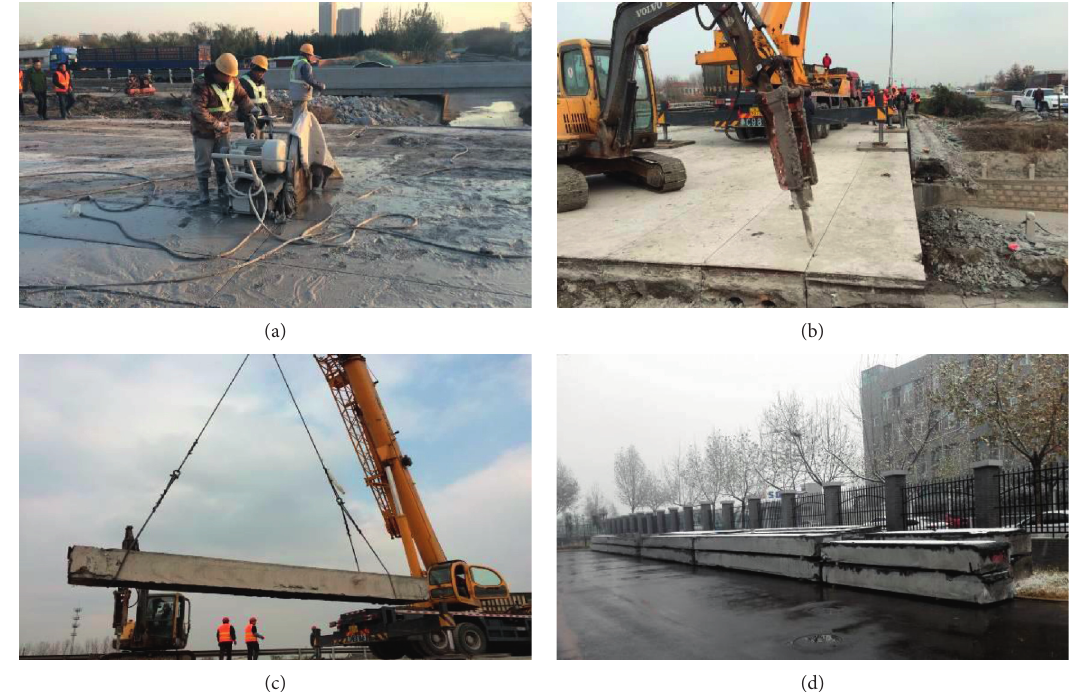
Figure 1: In situ construction: (a) cutting; (b) demolish; (c) lifting; (d) storage.